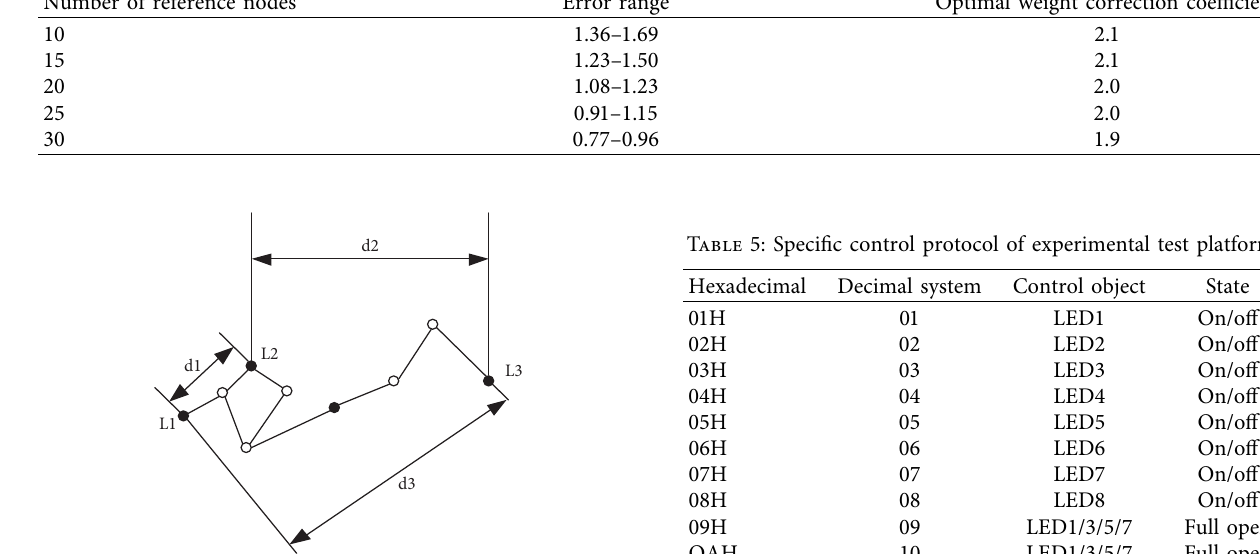
Figure 12: Wireless sensor network architecture.